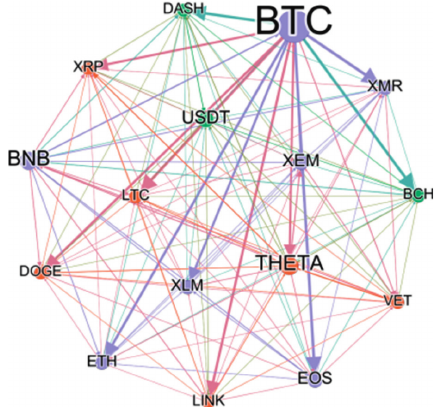
Figure 29: Risk spillover under D4.